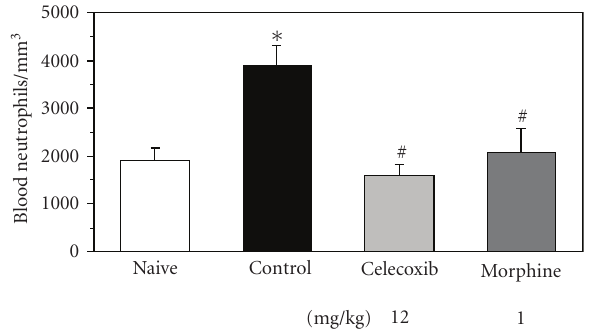
Figure 2: Blood neutrophil number in whole blood from na¨ıve, control, and treated periodontal-diseased rats. For specific cell counting (%), a smear of the blood was prepared and stained by Panotic L.B. haematological dye system and observed under a light microscope (1000-fold). Celecoxib (12mg/kg/day) or morphine (1mg/kg/day) was subcutaneously administered for 3 consecutive days, from 3rd to 5th day after ligature placement as described in Materials and Methods. ∗ and # indicate significant di ff erence ( P < .05) in relation to naive and control group, respectively; one-way ANOVA followed by Student-Newman-Keuls test, 4–6 animals per